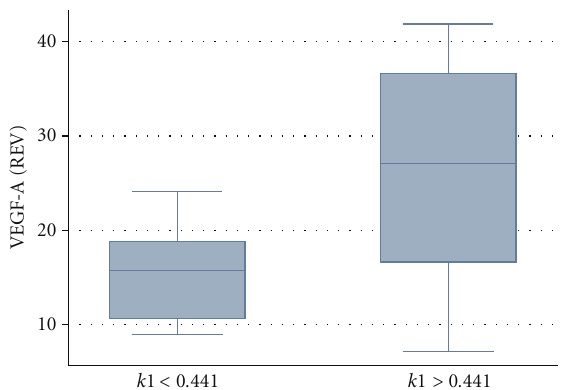
Figure 2: Low k1 (less than 0.441) values are associated with a low expression of VEGF-A.